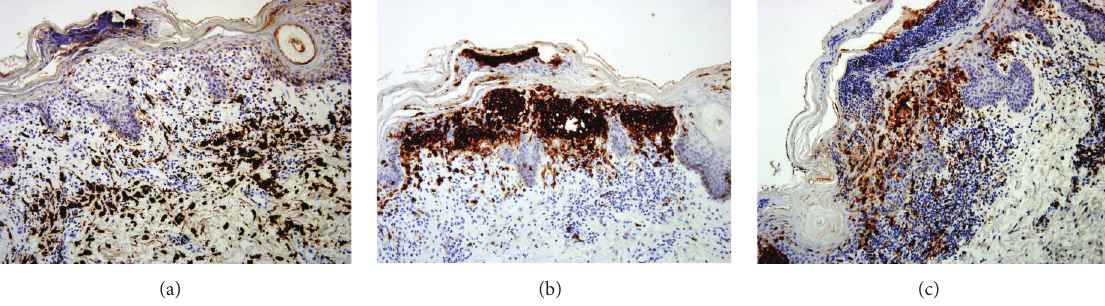
Figure 8: Skin biopsy: immunohistochemical stain showing positivity for CD68 (a), CD1a (b), and S100 (c).